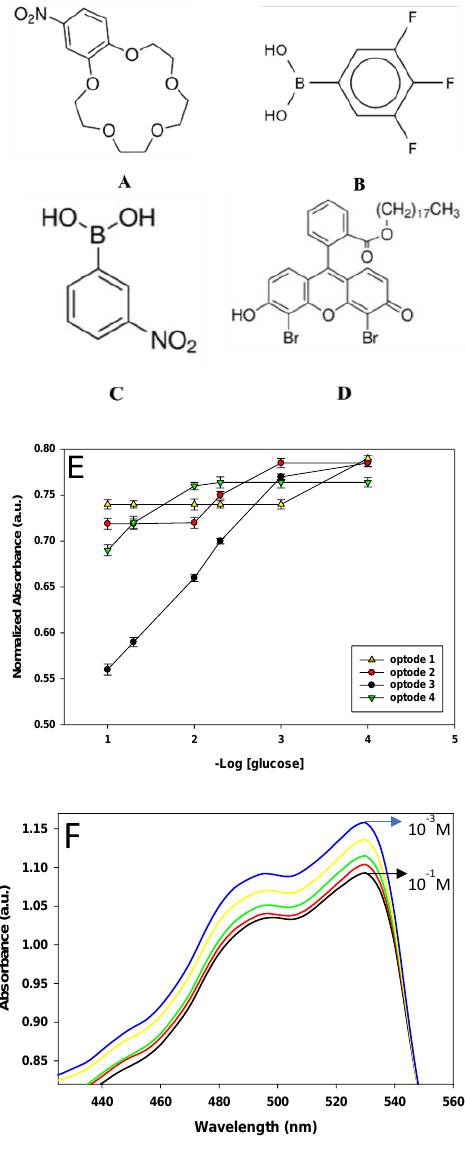
Figure 1. Chemical structures of the three ionophore ( A ) 4-nitrobenzo-15-crown-5, ( B ) 3,4,5-trifluorophenylboronic acid, ( C ) 3-nitropheny boronic acid; and ( D ) ETH 7075 chromoionophore. ( E ) Calibration curves of different optodes measured at λ max = 530 nm, the standard deviation was obtained through 5 measurements ( F ) UV-vis spectra of optode 3 at different concentrations increased gradually from 10 − 3 to 10 − 1